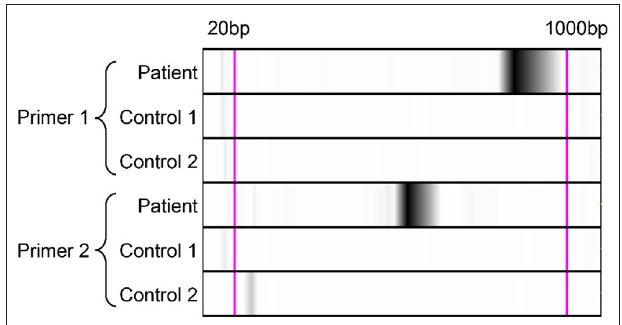
FIGURE 4 | Polymerase-chain-reaction and the capillary electrophoresis technique confirmed the Legionella gormanii infection in the patient. Lane Patient: the bronchoalveolar lavage fluid sample of the patient; Lane Control 1: the blank control; Lane Control 2: the negative control, the bronchoalveolar lavage fluid sample from a patient who was finally diagnosed without Legionella pneumonia.